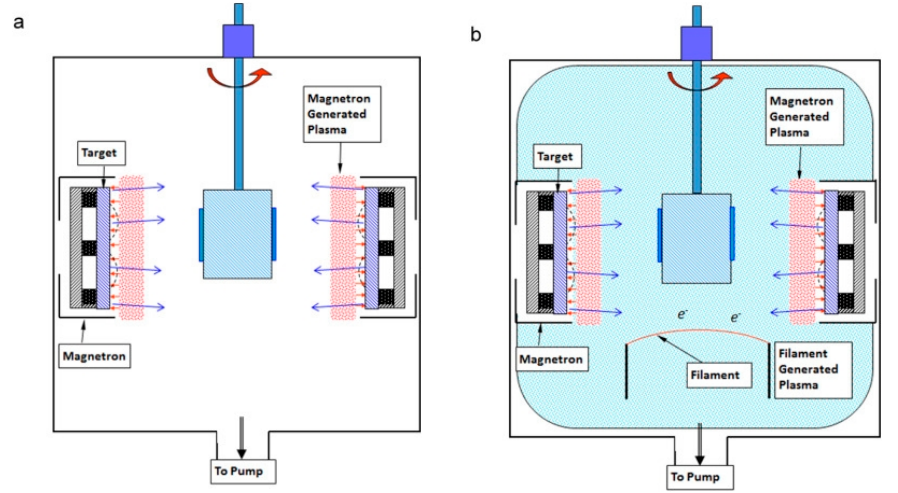
Figure 6. Schematic comparison between ( a ) conventional magnetron sputtering (MS), and the ( b ) plasma enhanced magnetron sputtering (PEMS) assisted process. Reproduced from [95] with permission. Copyright 2018 Elsevier.